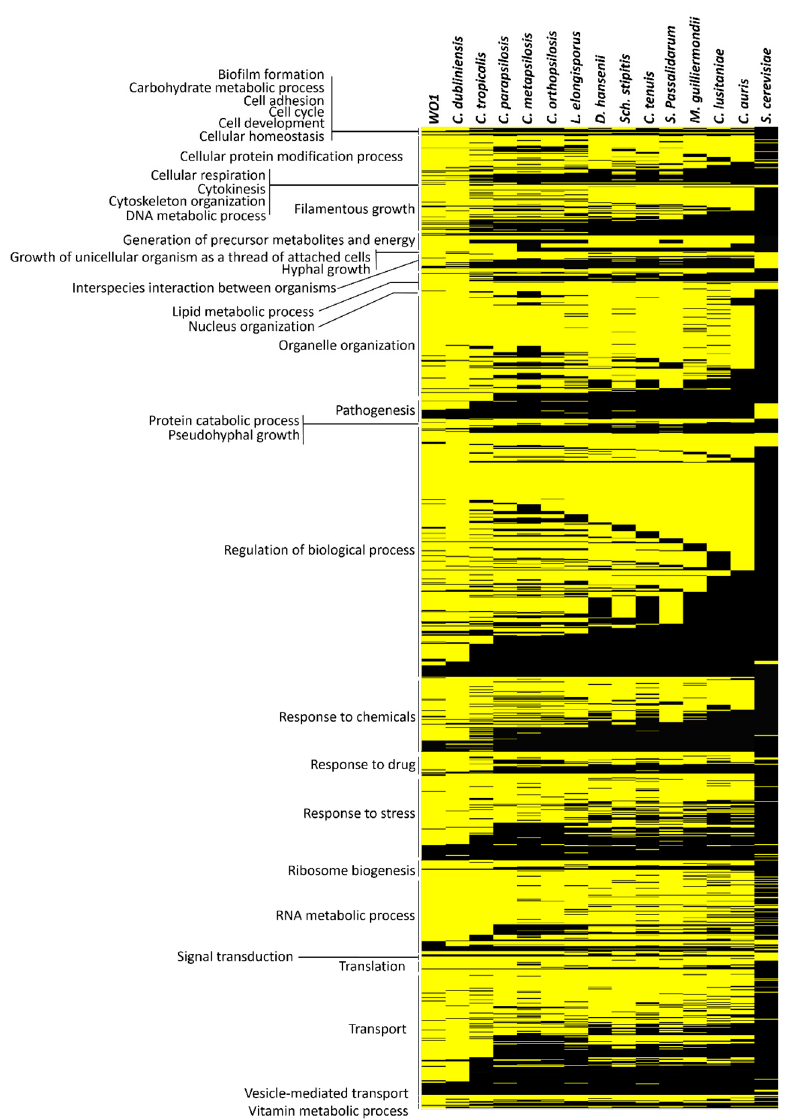
Figure 1. Conservation of functionally related clusters in divergent fungal lineages. The functionally clustered gene pairings from Candida albicans were analyzed for conservation of the pairings. The heat map depicts the conservation with either yellow (conservation of the pairing) or black (no conservation of the pairing).